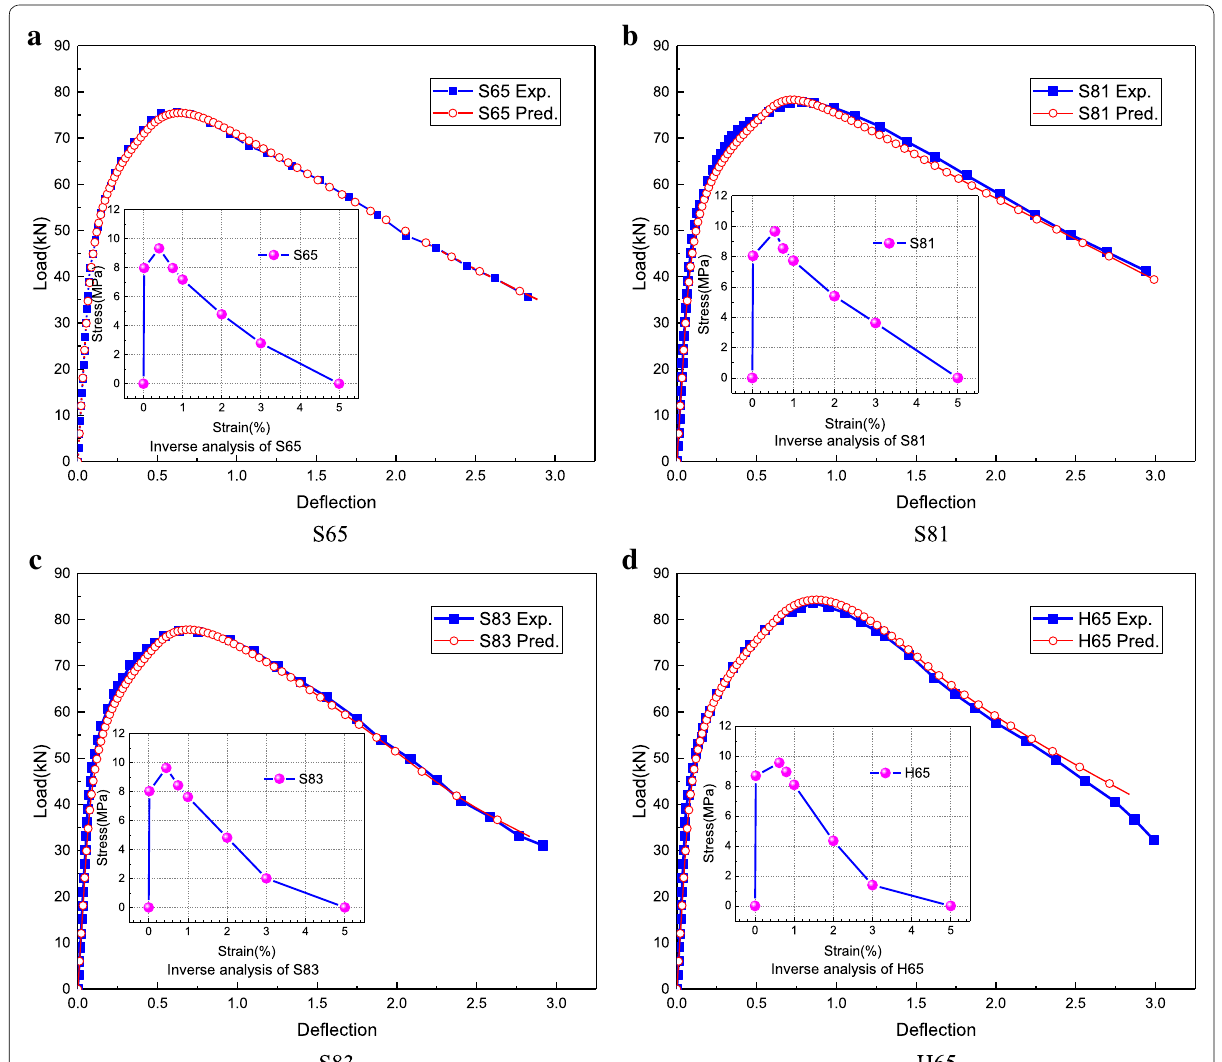
Fig. 19 Inverse analysis and four-point bending test results (inner: direct tensile stress–strain curves from inverse analysis and outer: experimental and numerical